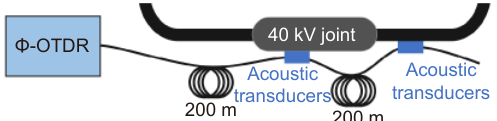
Fig. 12 | Experimental setup for discharge detection with two acoustic transducers attached to the 40 kV joint. (Figure redrawn after ref. 119 )